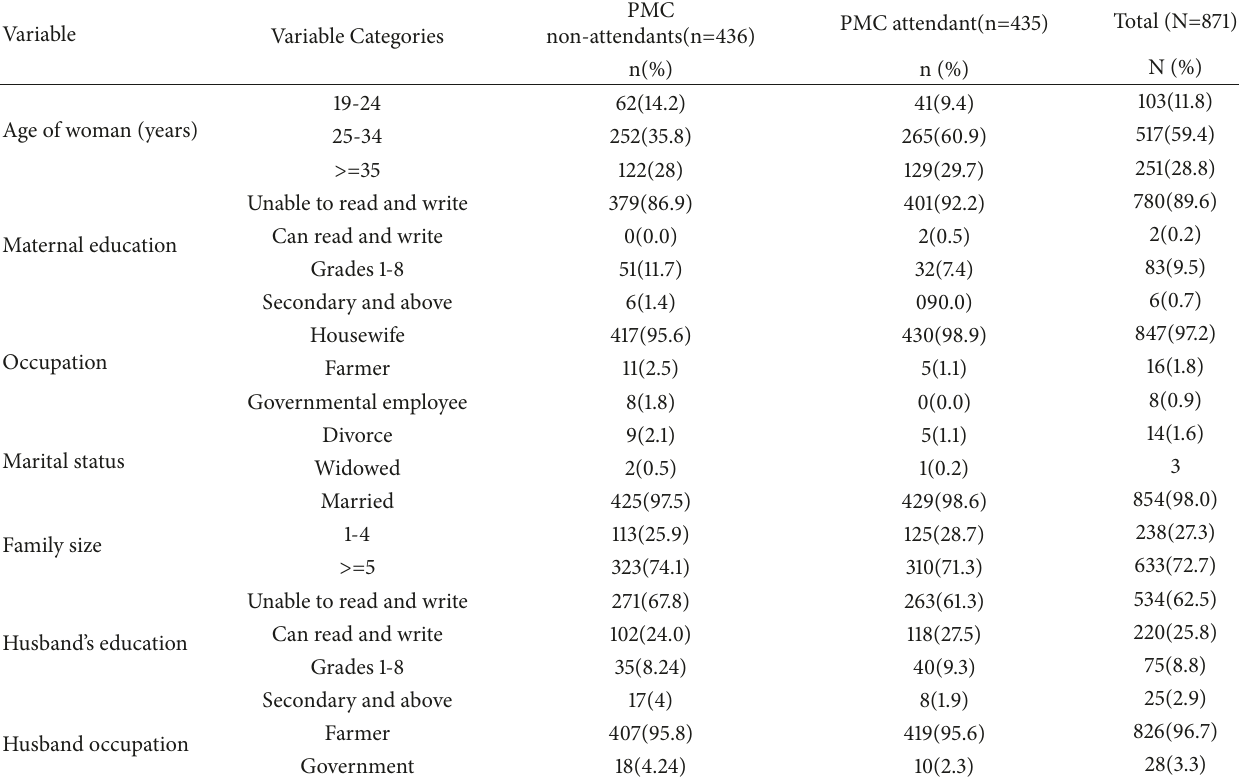
Table 1: Socio-demographic characteristics of the mothers in Libo Kemkem District, Amhara Region, North West Ethiopia 2017.